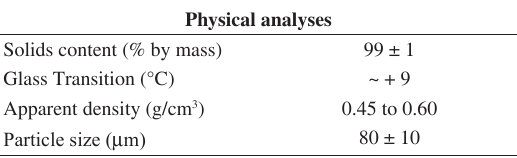
Table 3. Physical characteristics of Va/Veova copolymer powder.